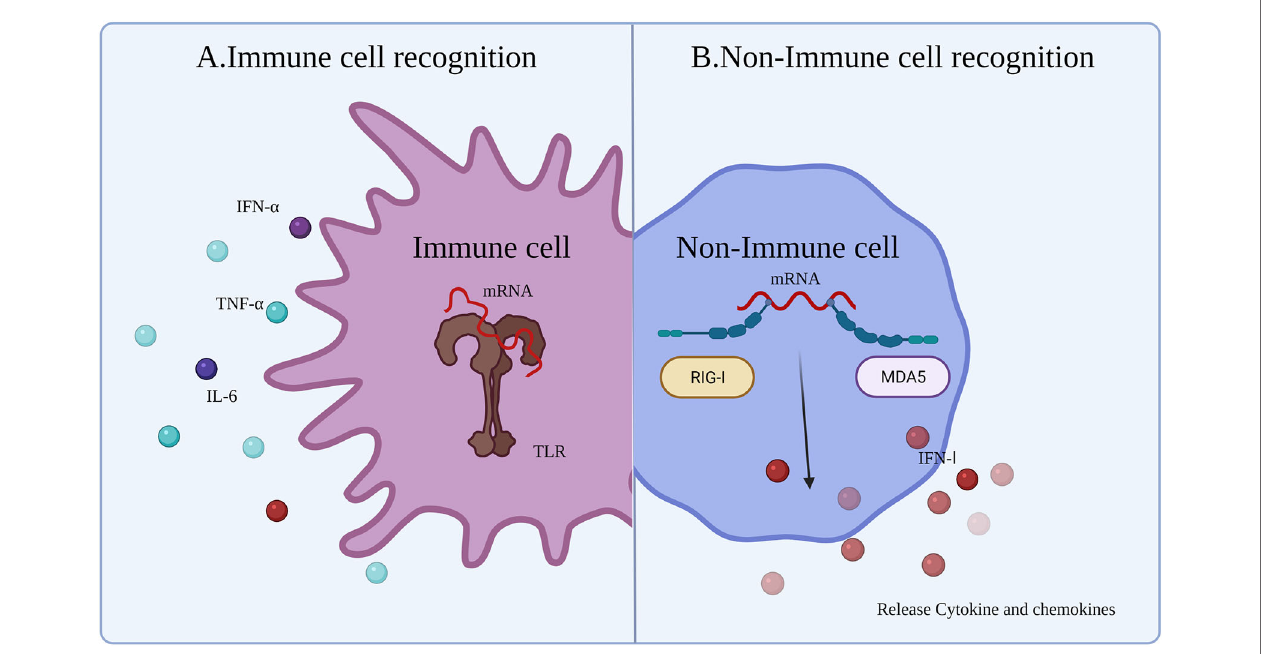
FIGURE 3 | Innate immune response to mRNA vaccine. After the exogenous mRNA enters the human body, it produces an innate immune response. (A) The response occurs mainly in the immune cells. Immune responses are activated though TLRs to detect PAMPs (exogenous mRNA). (B) The response occurs mainly in non-immune cells. RIG-1 and MDA5 sense the exogenous mRNA and then induce an IFN I